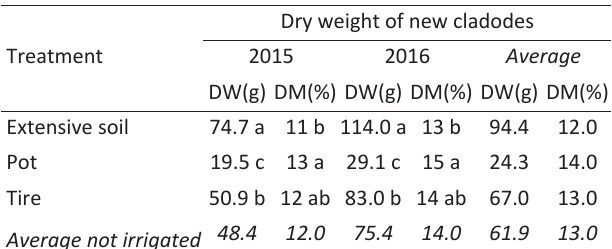
Table 3 - Dry weight (DW, grams) and dry matter percentage (DM, %) in new cladodes in the three trial treatments in the two years of trial and average